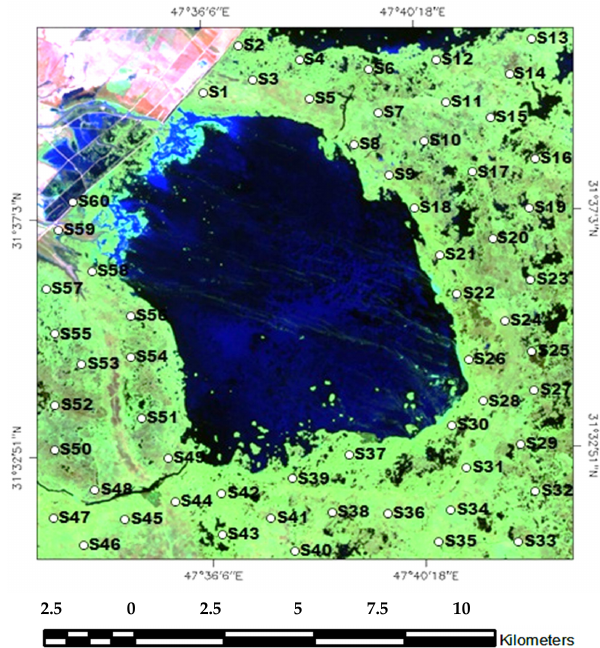
Figure 3. Satellite image showing the soil sampling stations.